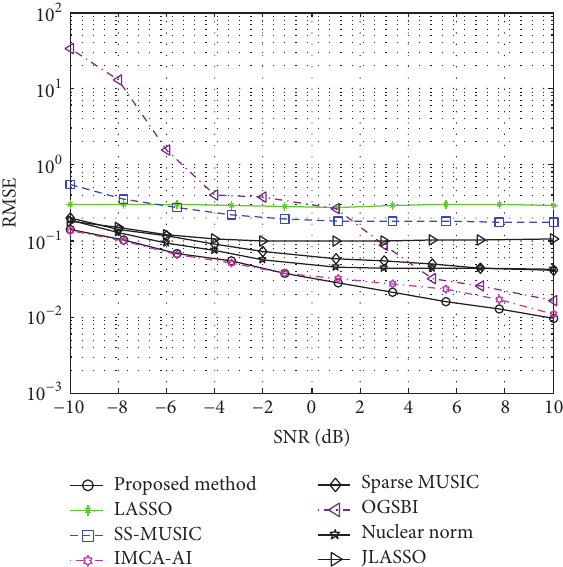
Figure 9: RMSE versus SNR (𝑇 = 300, 𝐾 = 2)